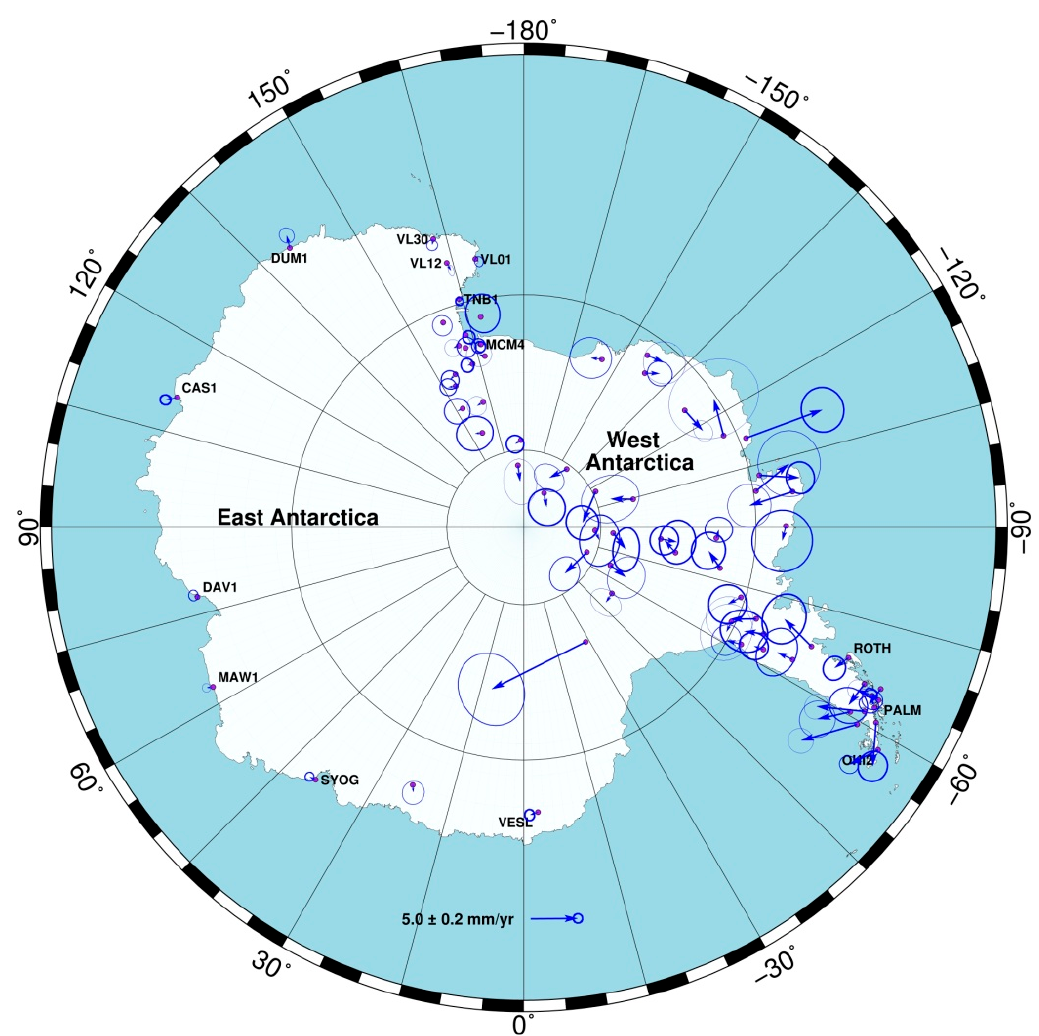
Figure 9. Residual horizontal displacement map (mm/yr) at continental scale (± σ ).